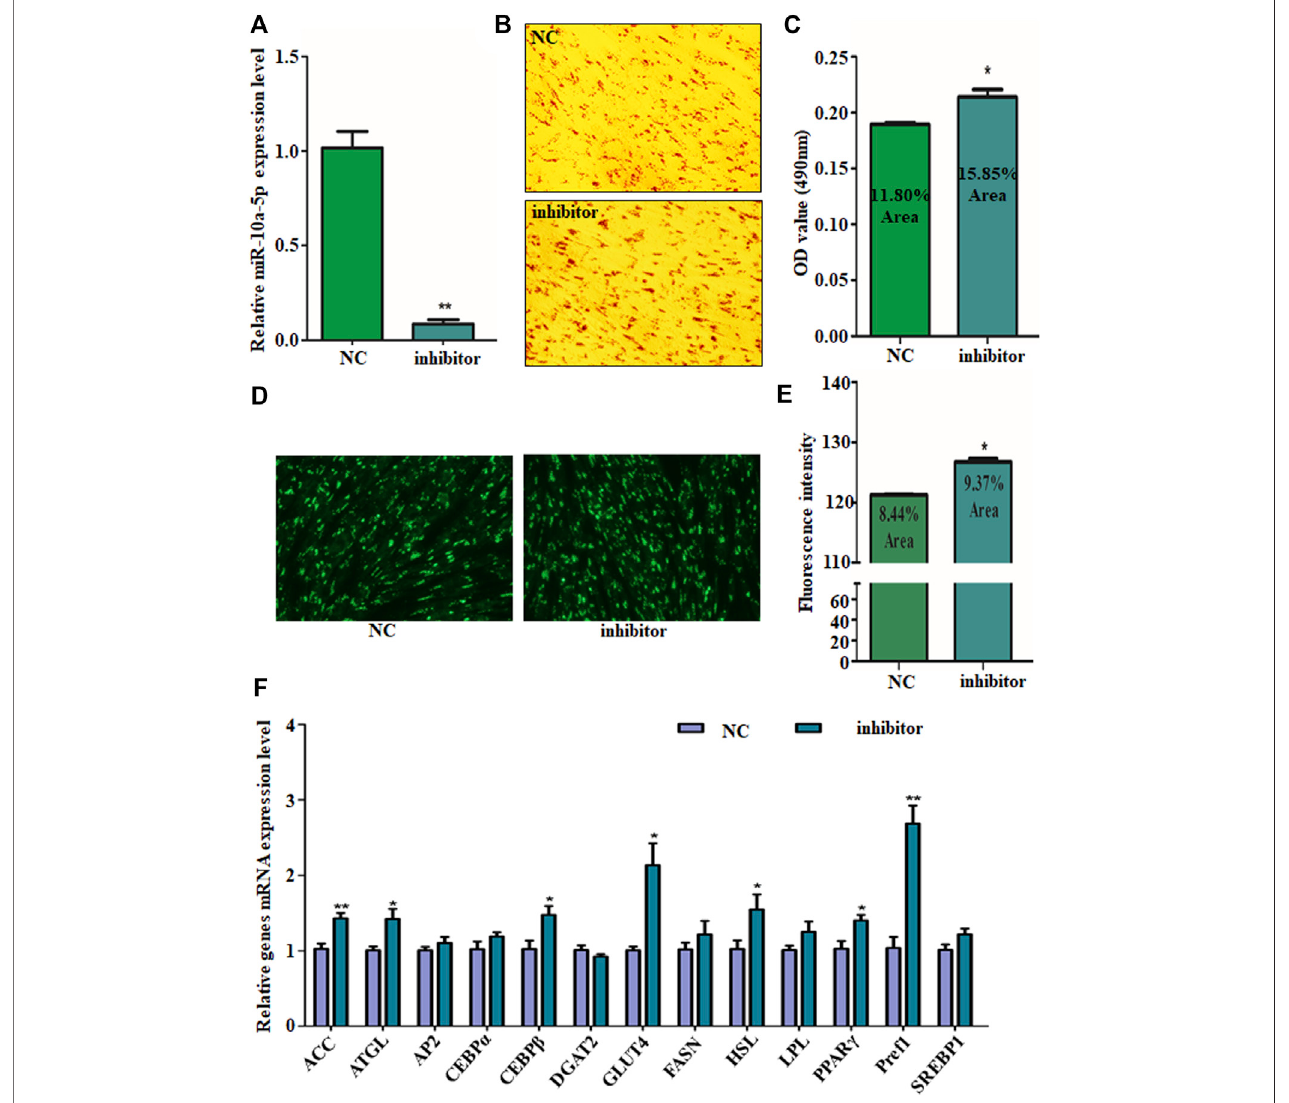
FIGURE 3 | Silence of miR-10a-5p promotes GIPC differentiation. (A) qRT-PCR analysis of levels of miR-10a-5p expression in GIPCs with inhibitor or control transfected for 24 h. (B) Representative images of Oil Red O staining of GIPCs with miR-10a-5p inhibitor or control and (C) semi-quantitative assessment of Oil Red O content absorbance detection at 490 nm. (D) Representative images of mature adipocytes stained with BODIPY and (E) stained area was measured using ImageJ. (F) qRT-PCR analysis of levels of genes expression in GIPCs with miR-10a-5p inhibitor or control. N > or (cid:1) 3, * indicates p values < 0.05 and ≥ 0.01, ** indicates p values <